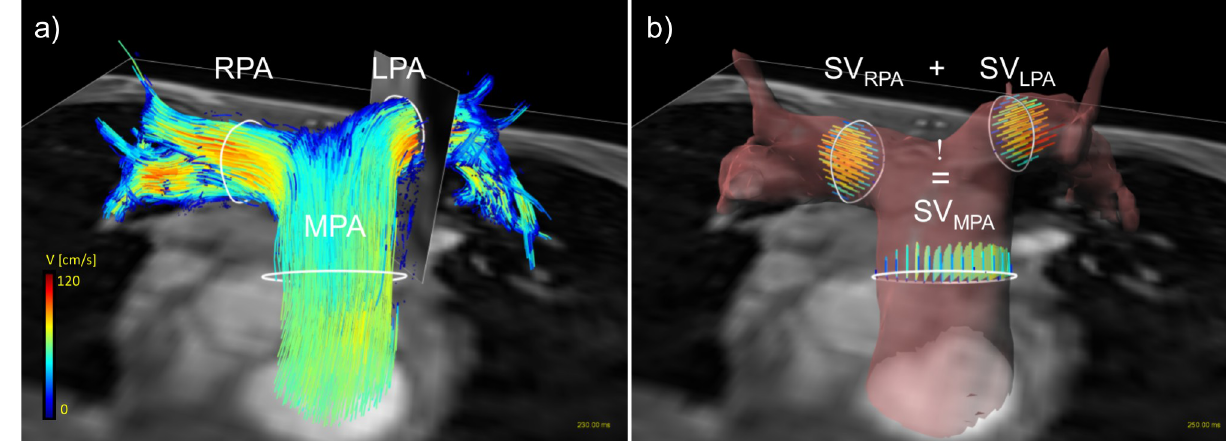
Fig 1. Data analysis of a 4D Flow MRI dataset. Fig 1 a) shows contour-placement (white) in the main, right and left pulmonary artery (MPA, RPA, LPA, respectively) in a healthy volunteer. The oblique cutplane transecting the LPA matches the 2D Flow geometric orientation to guarantee the exact comparability of data. Visualization in (a) was achieved by using particle-traces, projected in both flow directions, with contours as seed points. Color- coding was performed with respect to the acquired velocities. (b) the principle of the Conservation of mass-analysis in the same volunteer. Stroke volume in the MPA should equal the sum of stroke volume in the RPA and LPA to proof data consistency. The vessel wall was reconstructed based on complex difference and surface shading of the 4D Flow MRI